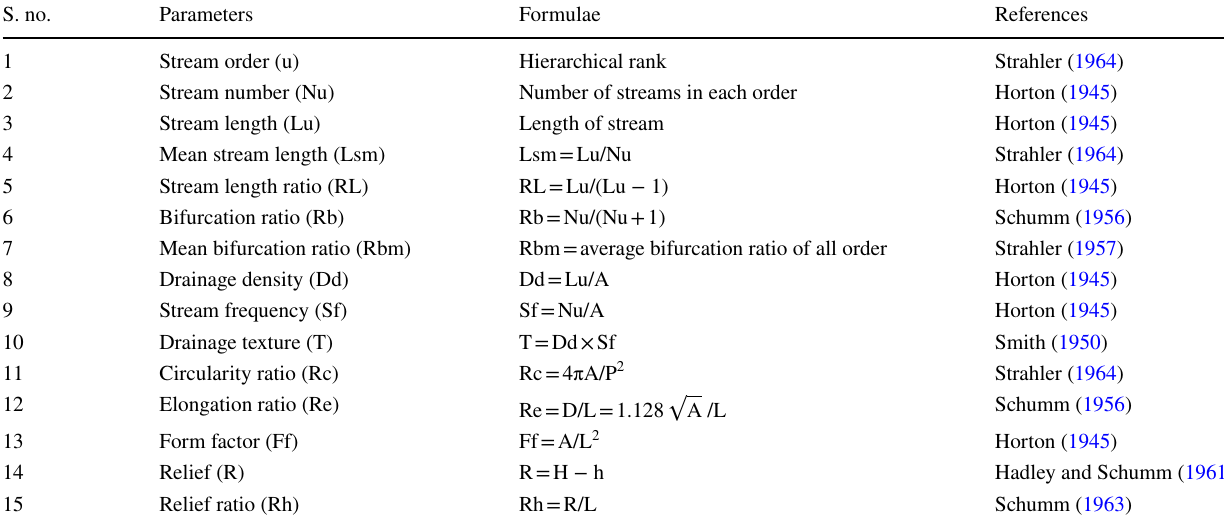
Fig. 3 Methodology carried out to generate the drainage network Table 1 Morphometric parameters along with corresponding formulae S.